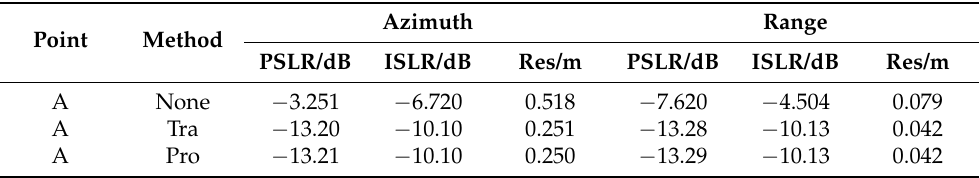
Table 7. Point Target Analysis of Point A in Signal s 9 with Different MoCo Schemes.